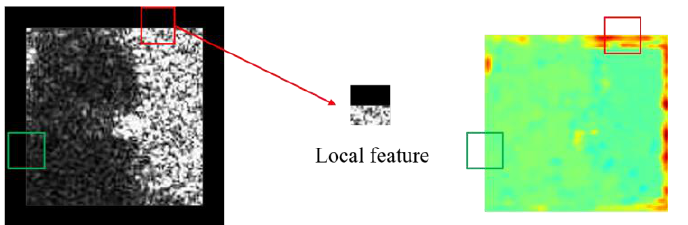
Figure 2. SAR image with P ≠ 0 and the corresponding heatmap. Red circle indicates highly active areas on the heatmap and green circle indicates inactive areas.